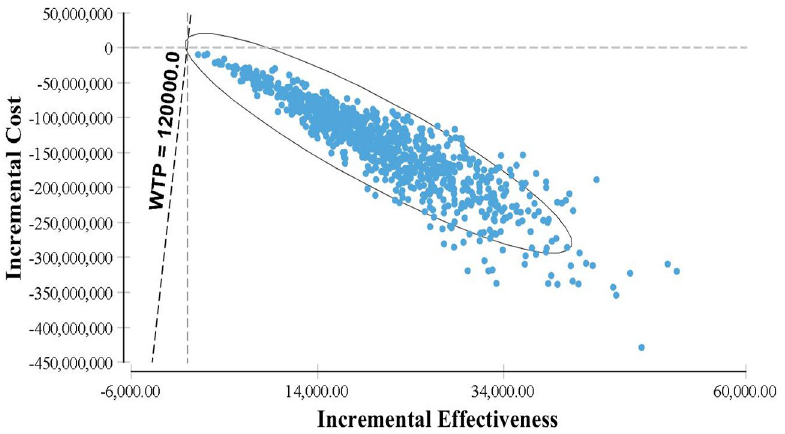
Fig 3. Scatter plot showing results of Monte Carlo probabilistic sensitivity analysis for PPV23 vaccination programme vs no